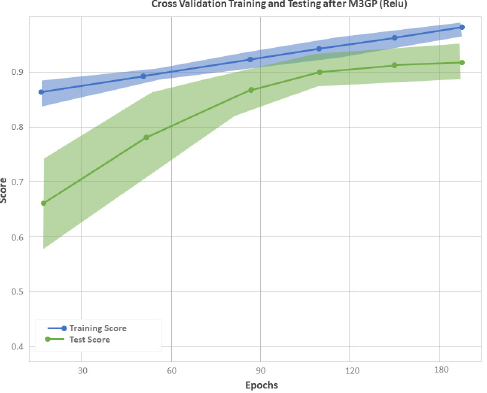
Figure 13. Training and testing validations scores for the DL after M3GP (ReLU function).